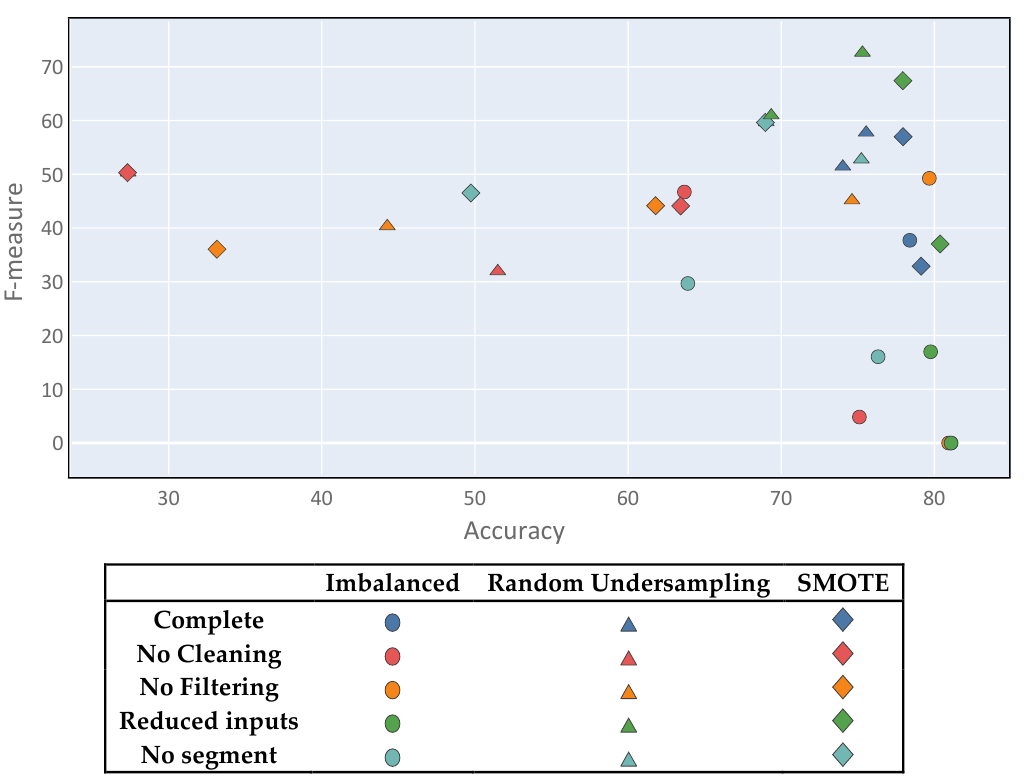
Figure 9. Multi-objective problem visualization.